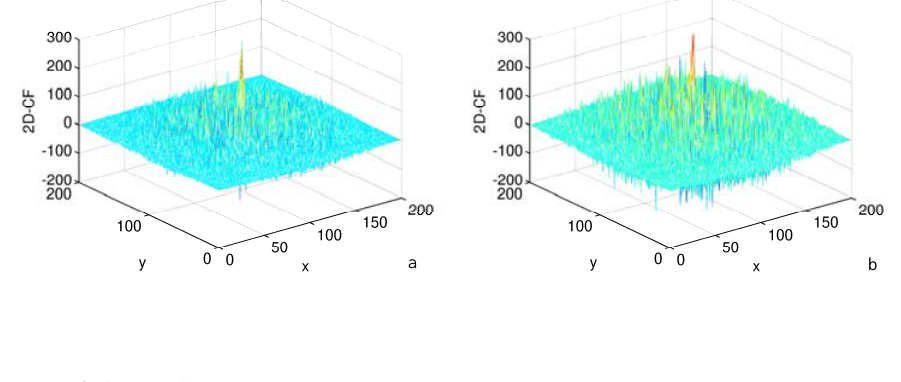
Figure 3. The effects of sea state on 2D-CF. a and b are 2D-CF values between co-polarization channels, SNR is 1.1 in Fig2 a. and 3.0 in Fig2 b.